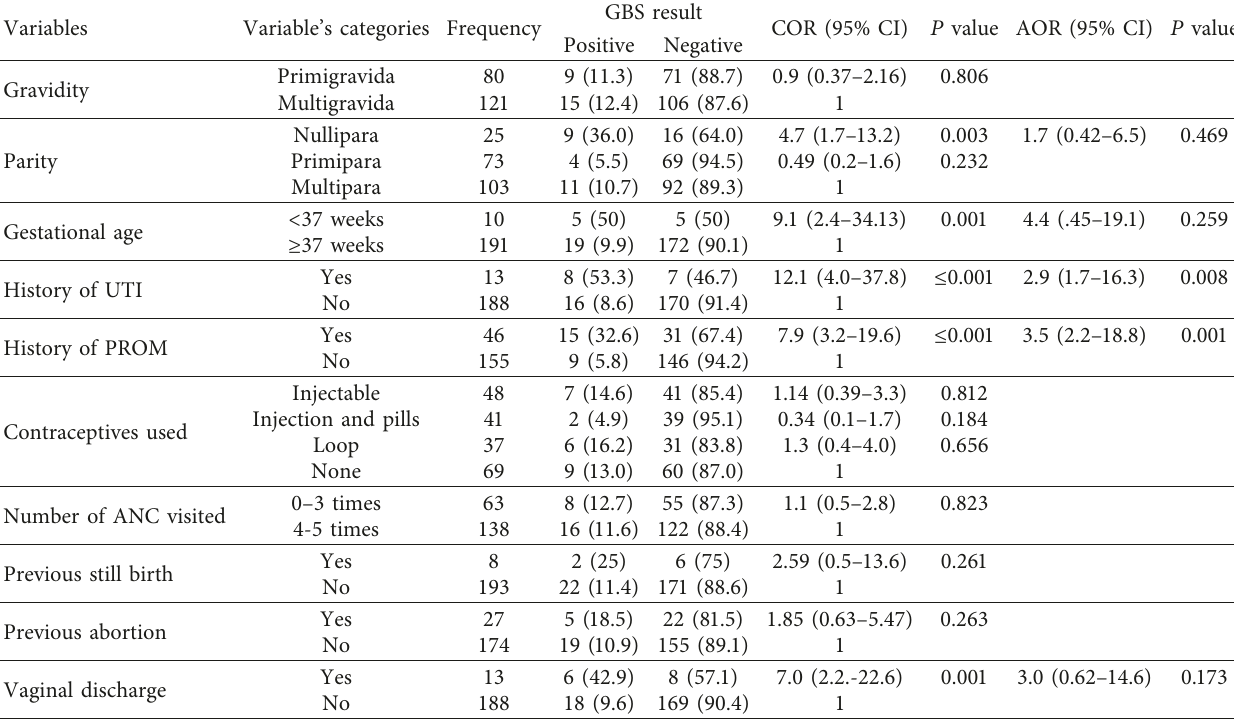
Table 3: Multivariate analysis of clinical factors with GBS colonization among pregnant women.